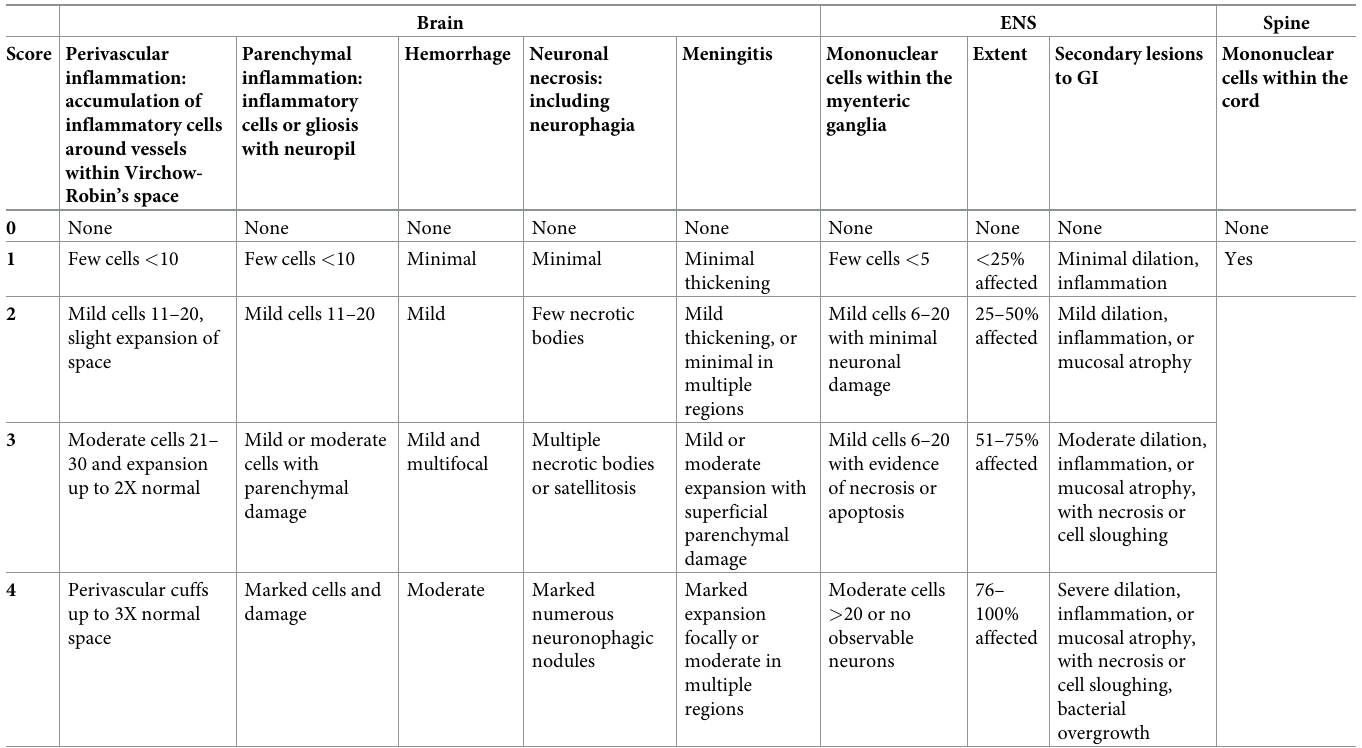
Table 1. Histological